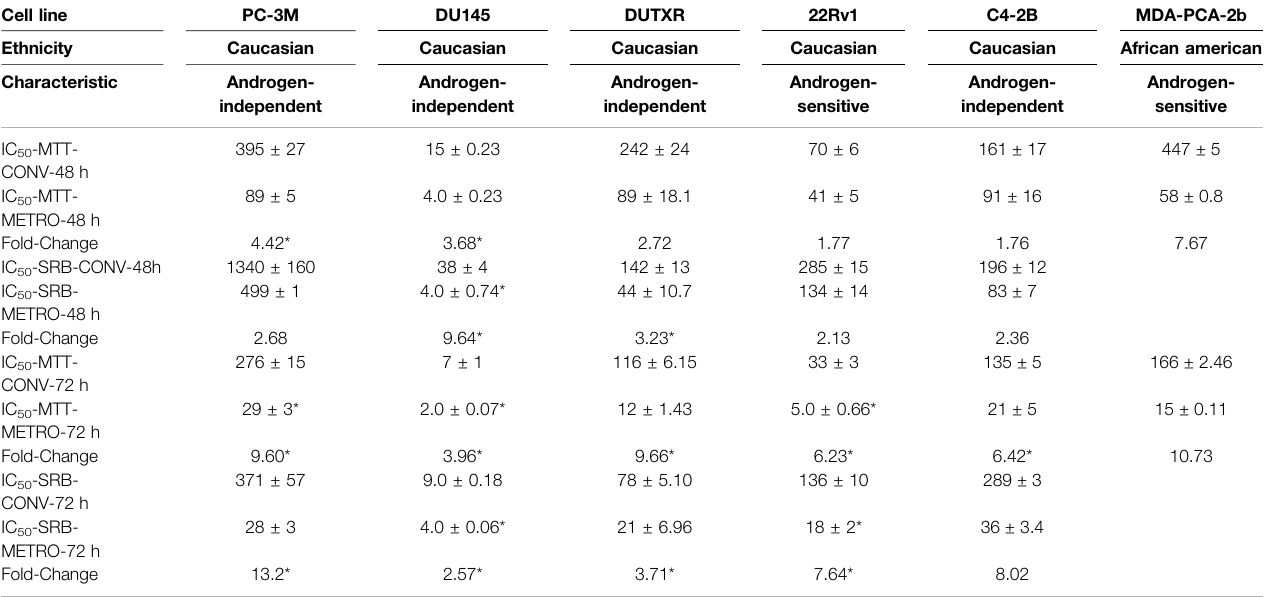
TABLE 1 | In vitro chemo-sensitivity (IC 50 values for MTT and SRB assays) data presented (nM) as mean ± SEM of at least three independent studies ( n (cid:1)